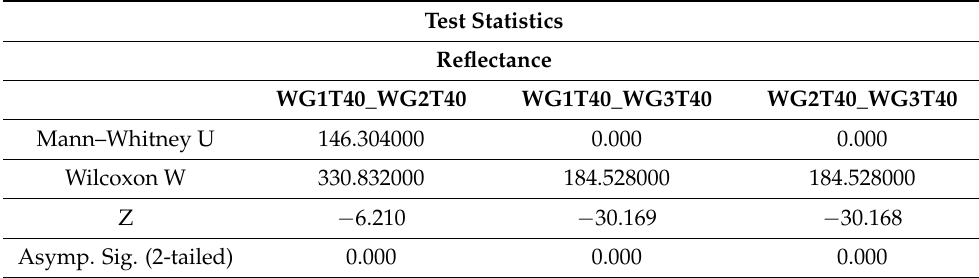
Table A12. Test statistics table of the Mann–Whitney U test for specular solar reflectance according to the holding time of 40 min.